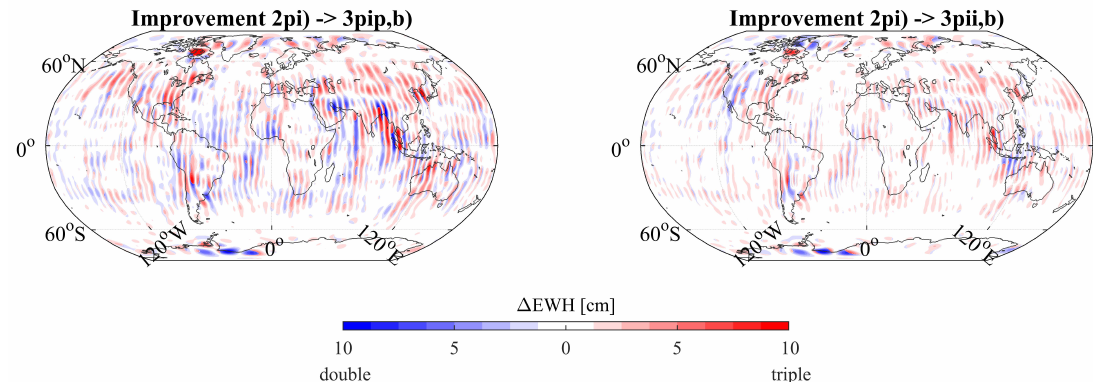
Figure 5. Di ff erence of estimated vs. reference solution (up to d / o 50) of triple-pair scenarios 3pip,b and 3pii,b compared to double pair scenario 2pi in EWH [cm] of the seven-day solution from 08 / 01 / 2002 until 14 / 01 / 2002. Red means the triple-pair scenarios are closer to the truth, blue means the double pair scenario is closer to the truth. ( a ) Comparison of double pair scenario 2pi to triple-pair scenario 3pip,b. ( b ) Comparison of double pair scenario 2pi to triple-pair scenario